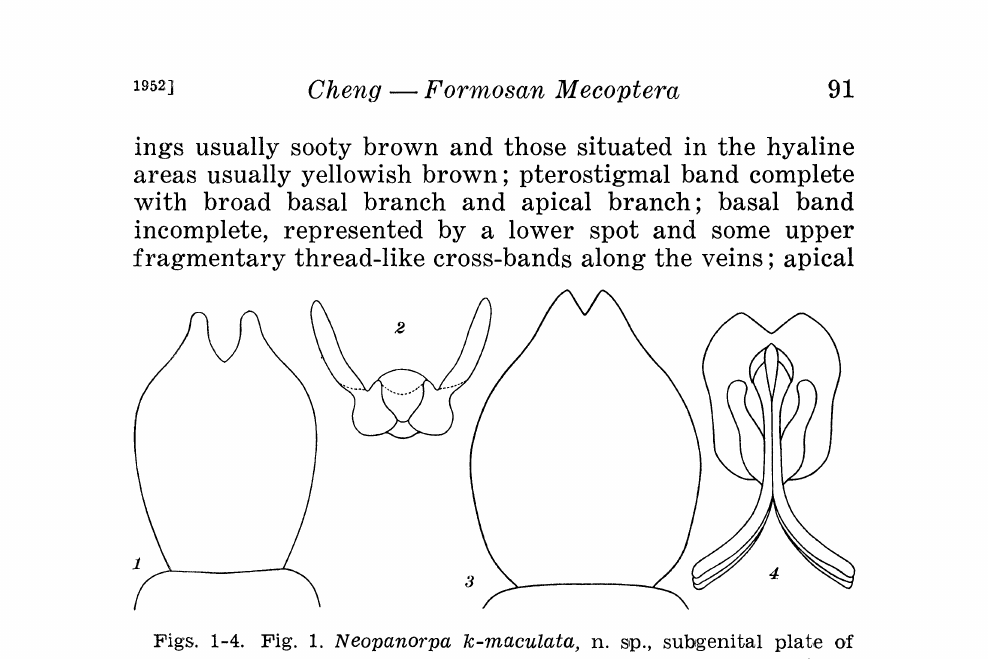
Figs. 1-4. Fig. 1. Neopanorpa k-maculata, n. so., subgenital plate of female (allotype). Fig. 2. Neopano.rpa k-maculata, internal skeIeton of eighth segment o.f female. Fig. 3. Panorpa lintienshana, n. sp., subgenittl plate o,f female (alloWpe). tig. 4. Panorpa lintienshana, internal skeleton of eighth segment of